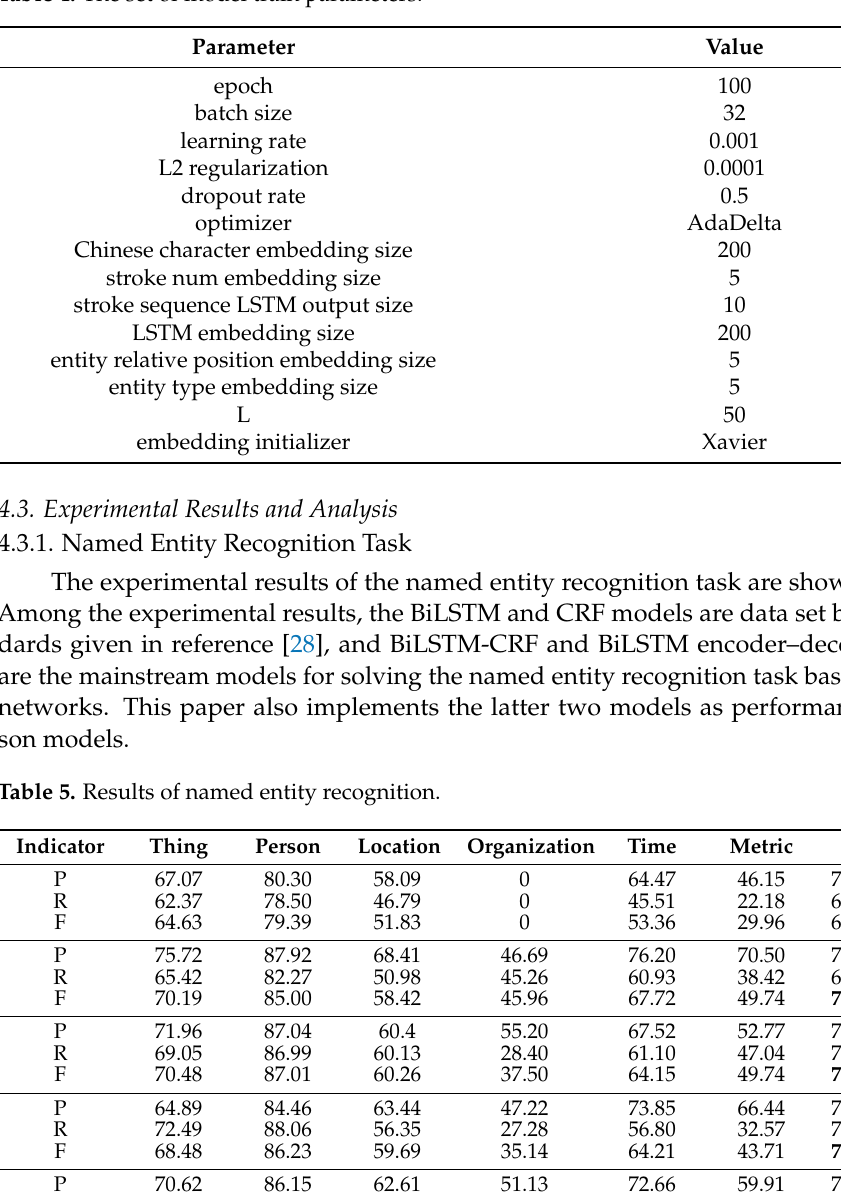
Table 4. The set of model train parameters.